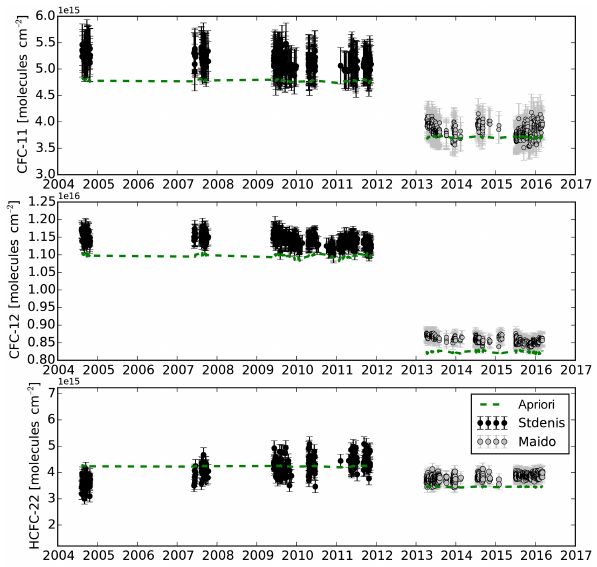
Figure 4. The time series of the total columns and total uncertainties of CFC-11, CFC-12 and HCFC-22 at St Denis (black) and Maïdo (grey), together with the a priori total columns at both sites (green dash lines). The error bar contains both systematic and random un- (cid:19) (cid:18)q ε 2 s + ε 2 r certainties from SFIT4 retrieval